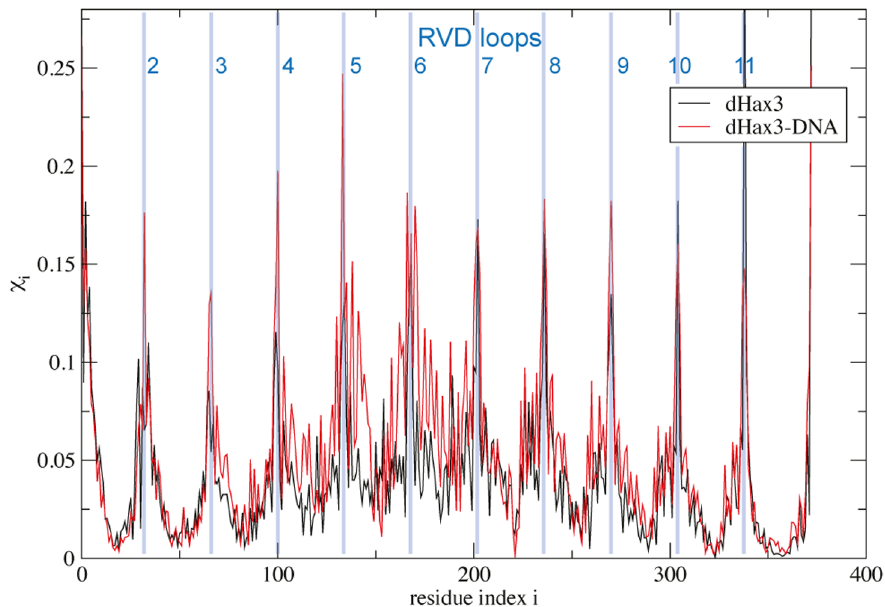
Figure 3. Distribution of local conformational changes in the elongated dHax3 structures obtained after application of an external force with magnitude F =1.0 A˚. The deformation value for the residues is plotted (see Methods, lines are used for better visibility). Positions of the RVD loops are indicated by blue lines.